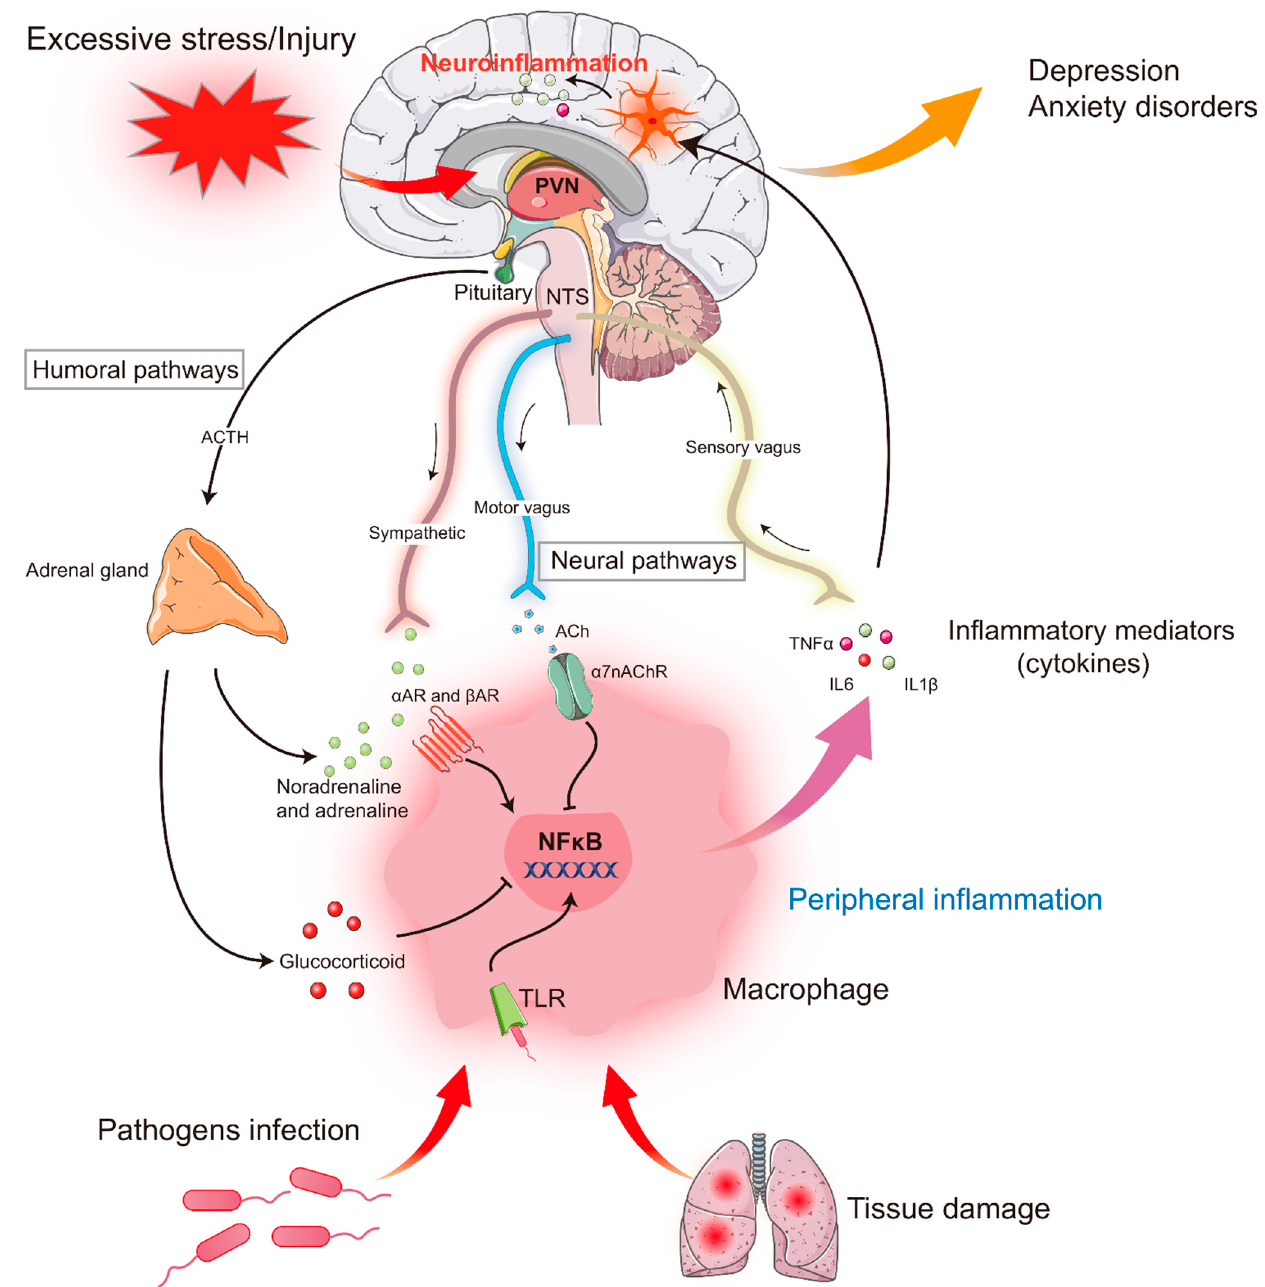
Figure 1. Stress-induced periphery inflammation and neuroinflammation in stress-related disorders: mechanisms and consequences interaction between the immune system, HPA axis, and sympathetic nervous system. Exposure to traumatic and stressful events in individuals may facilitate increased immune activity in both the periphery and the central nervous system (CNS) by activating the HPA axis and the sympathetic nervous system (SNS). HPA axis activation results in the release of glucocorticoids, which modulate the inflammatory response by suppressing the expression of pro-inflammatory cytokines by immune cells. However, overactivity of the SNS increases the release of pro-inflammatory cytokines. These cytokines access the brain via afferent fibers (e.g., vagus nerve) or through the damaged blood–brain barrier to activate microglia, which in turn contribute to neuroinflammation via secretion of pro-inflammatory cytokines in the brain. It should be noted that stress is common throughout life. The level of stress-induced inflammation and its influence on emotional behavior are closely related to stress inten- sity. In the face of acute stress, the body’s immune system will respond quickly in a short